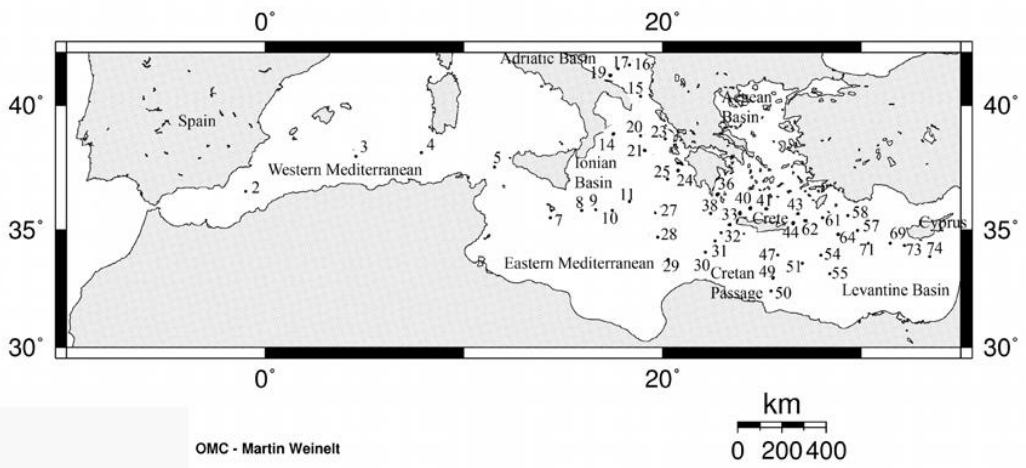
Fig. 1. Location of the stations samples for flow cytometry during the METEOR cruise M31/1 (30 December 1994 to 5 February 1995) conducted in the Mediterranean Sea in the frame of the POEM/BC (Physical Oceanography of the eastern Mediterranean Sea – Biology, Chemistry) and the EU/MAST-MTP (Marine Science and Technology-Mediterranean Targeted Project) of the European Union program.